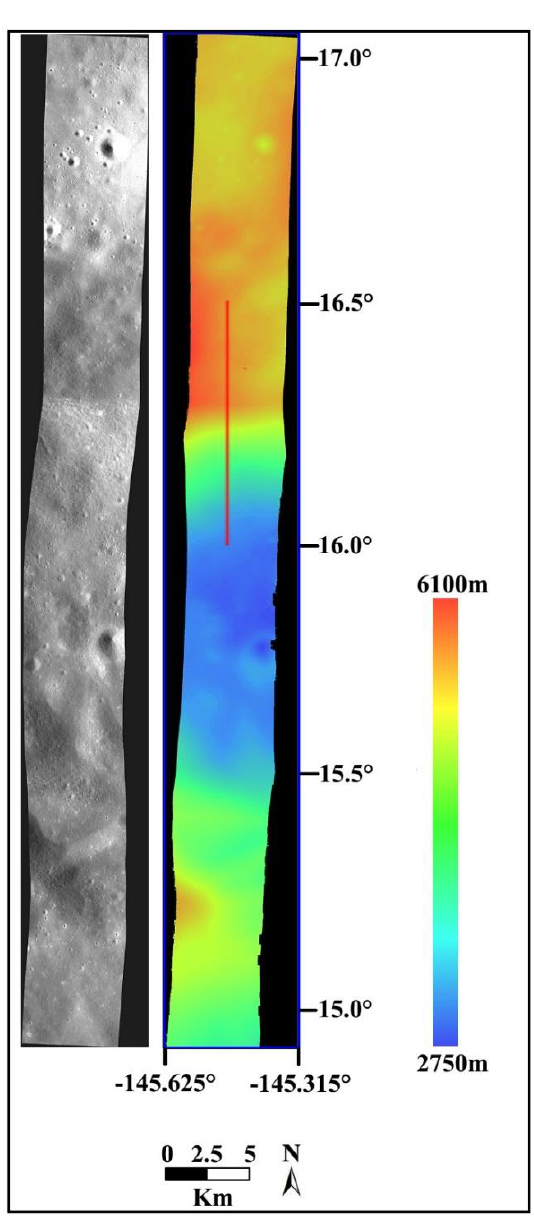
Figure 4. The DOM and DTM results generated from LRO NAC images. The red solid line indicates the positions of sampled points for plotting terrain